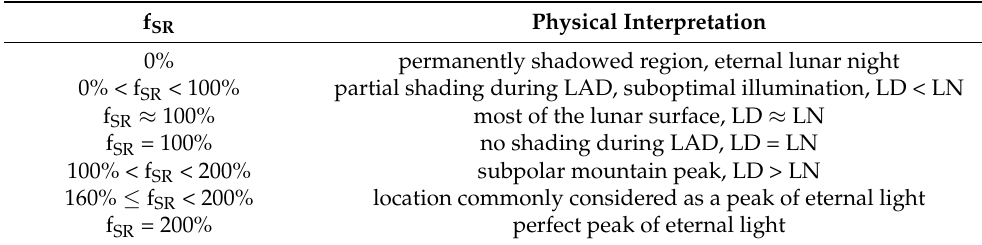
Table 5. Possible values of solar radiation factor with their